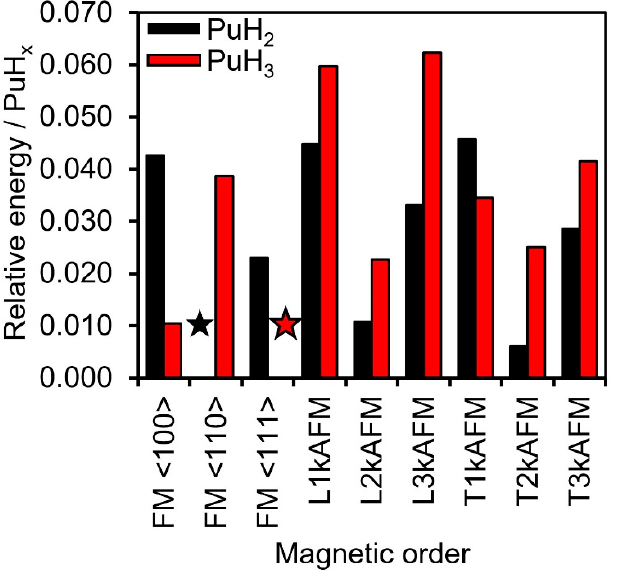
Figure 3. Relative energies of FM <100>, <110> and <111>, longitudinal AFM 1k, 2k and 3k, and transverse AFM 1k, 2k and 3k magnetic orders per PuH x for PuH 2 in black and for PuH 3 in red, calculated using HSE06sol+SOC. Black and red stars represent the most stable magnetic order for PuH 2 and PuH 3 , respectively.